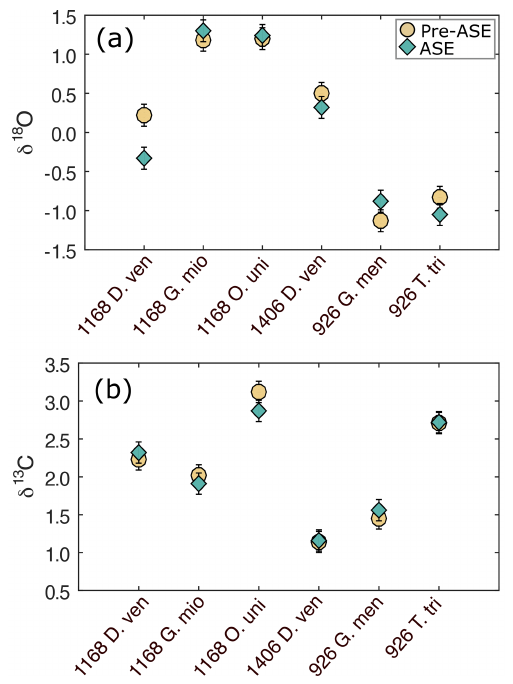
Figure 3. (a) δ 18 O and (b) δ 13 C results for the comparison of pre-ASE (yellow circles) and ASE-treated (blue diamonds) foraminifera. Uncertainties are shown as analytical precision of 0.14‰. There is no consistent offset between species pairs, sup- porting the use of stable isotopes in foraminifera from ASE-treated